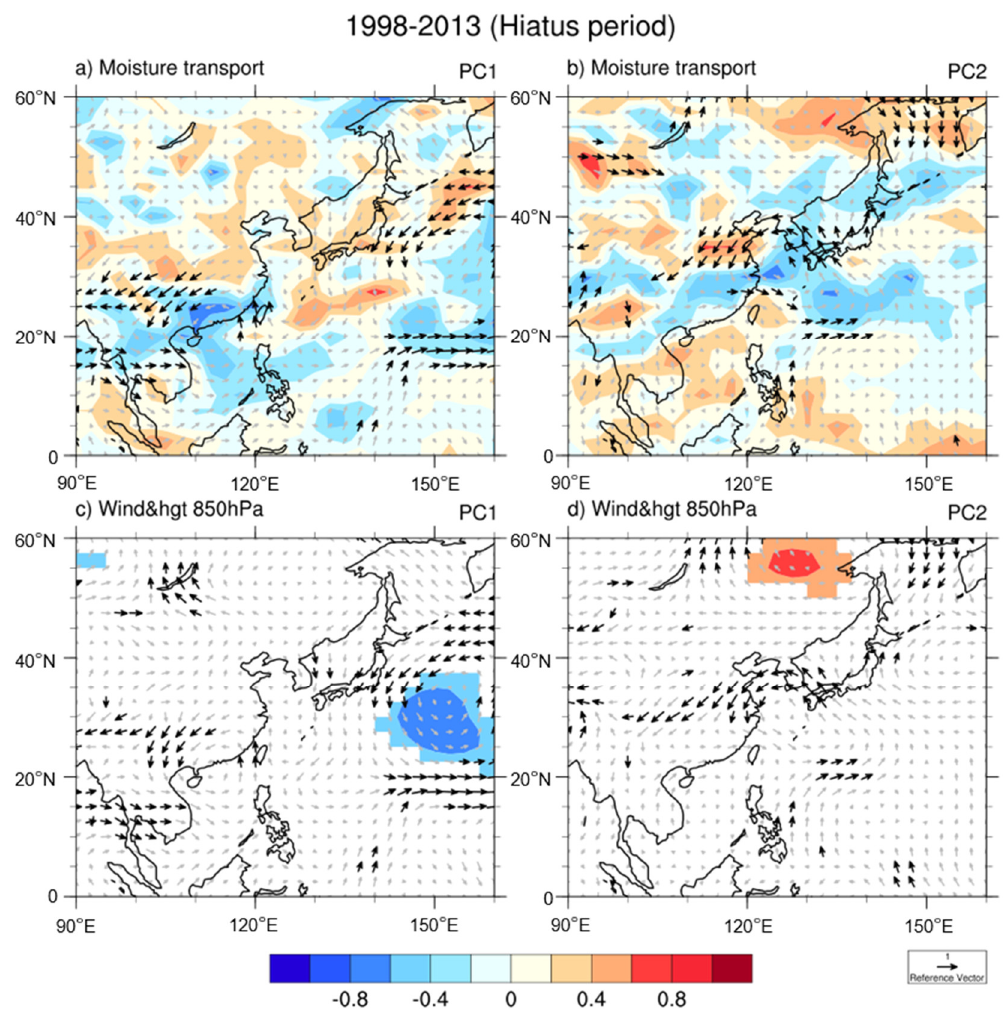
Figure 12. Same as Figure 8, but for the hiatus period (1998–2013).